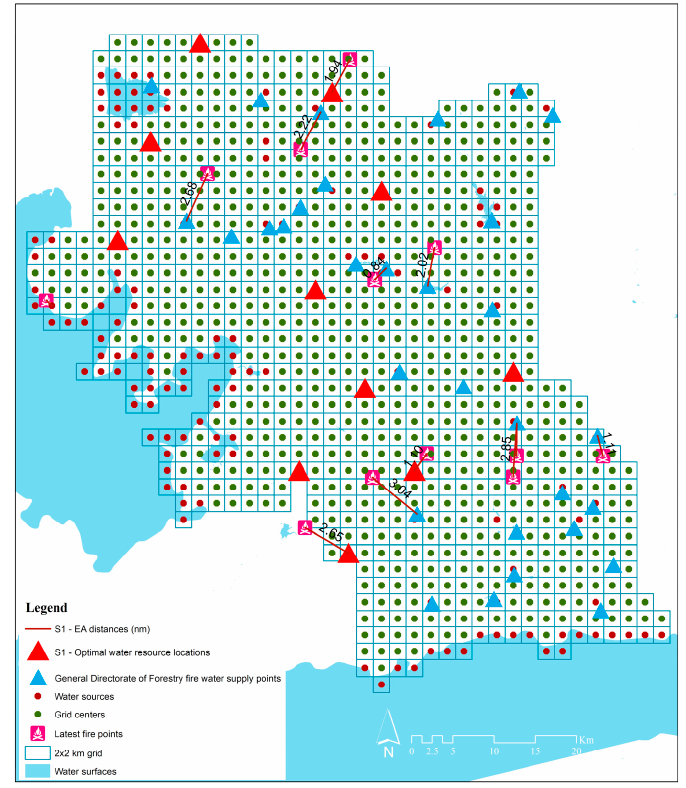
Figure 25. EA times in s1.